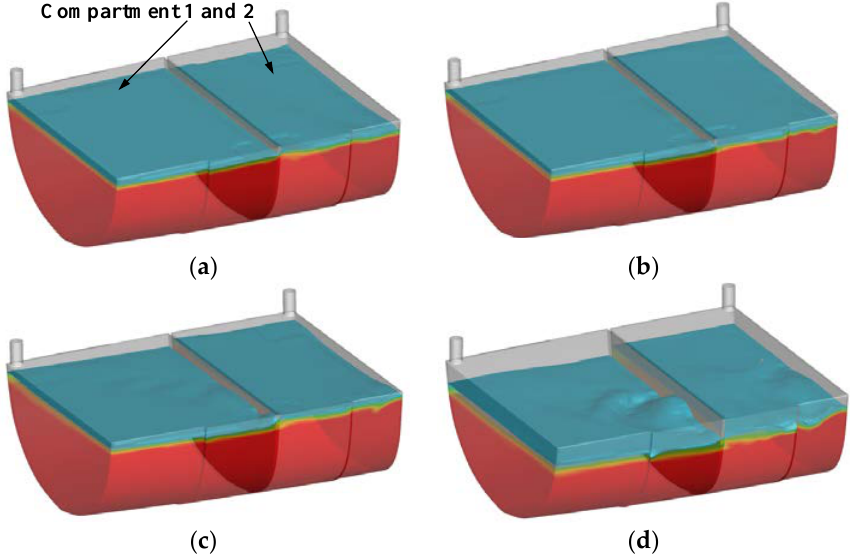
Figure 17. Comparison of water surface in compartments during symmetrical flooding at different